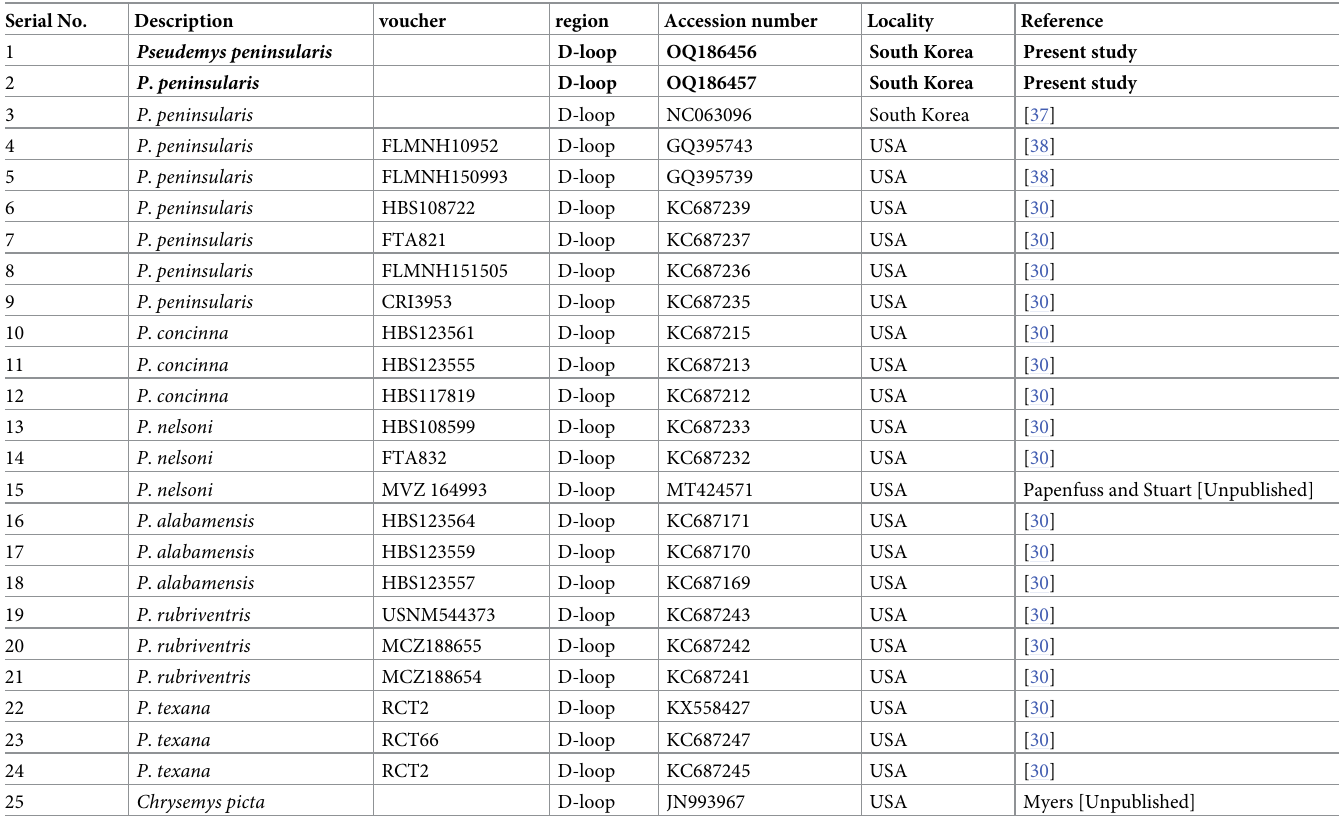
Table 1. List of sequences used in the present